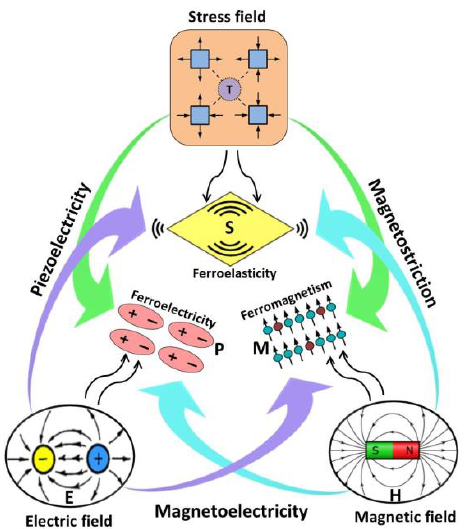
Figure 1. Schematic illustrating magnetic-elastic-electric couplings in multiferroic materials. Here, M is magnetization, S is mechanical strain, and P is dielectric polarization.